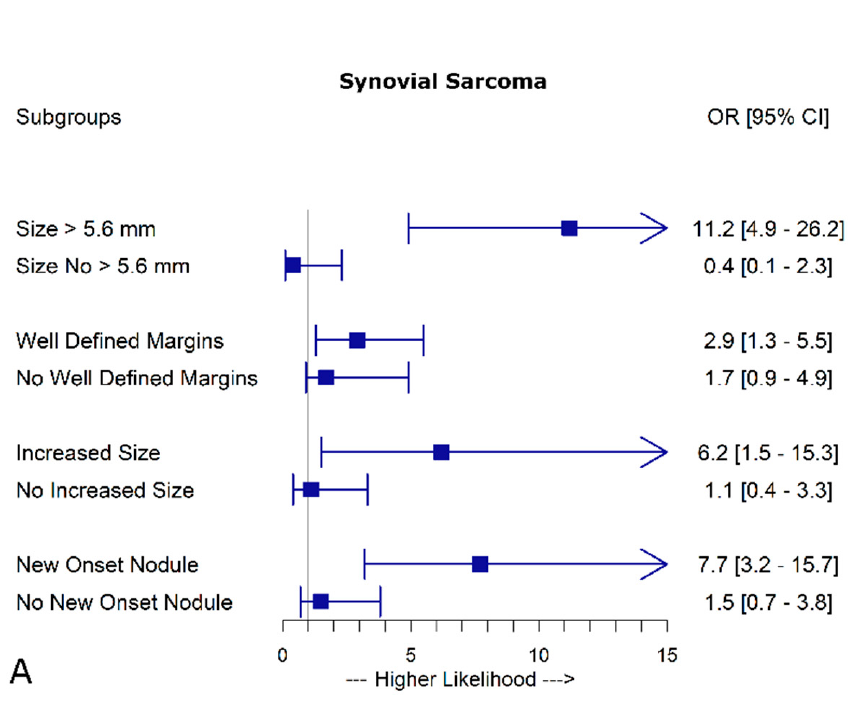
Figure 4. Interactions between multiple metastases and potential influencing factors. ( A ) Interaction between leiomyosarcoma and significant CT features. ( B ) Interaction between primary tumor grade